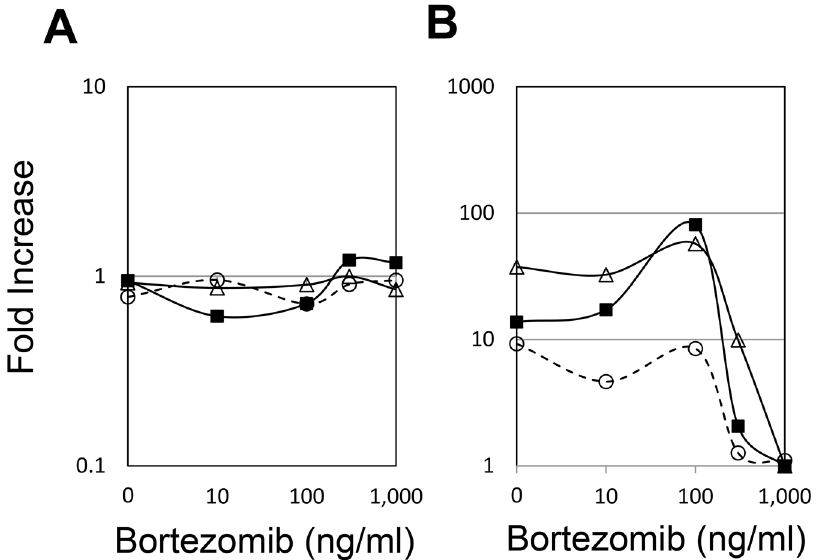
Fig 3. Bortezomib-induced inhibition of LPS-induced CXCL10 mRNA ex vivo . Peripheral blood obtained from 3 healthy volunteers was pre-treated with various concentrations of bortezomib for 1 h and then further stimulated with LPS or PBS (as the control) for an additional 4 h. The fold increase in (A) ACTB and (B) CXCL10 expression is shown. Each symbol represents a single